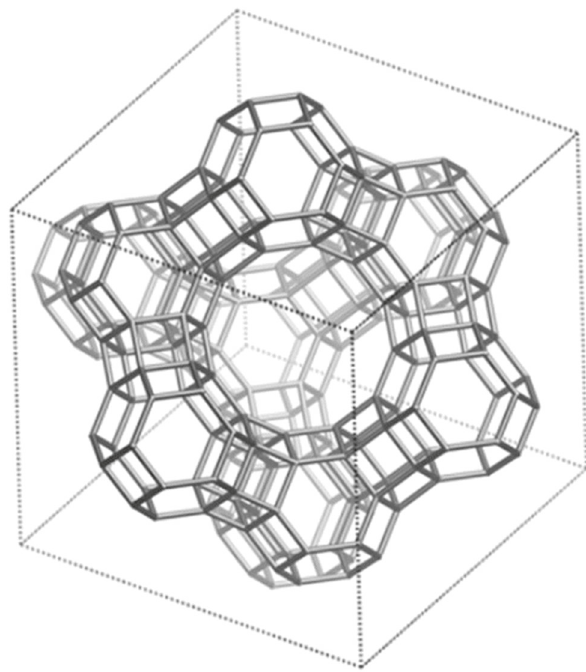
Fig. 1 Representative structure of the faujasite series of zeolites. Nodes in the framework correspond to atoms of Al or Si, linked to shared atoms of O that are not shown explicitly. Ions and neutral guests in the cages and channels are omitted for simplicity. Adapted with permission from the Royal Society of Chemistry, ref. 6